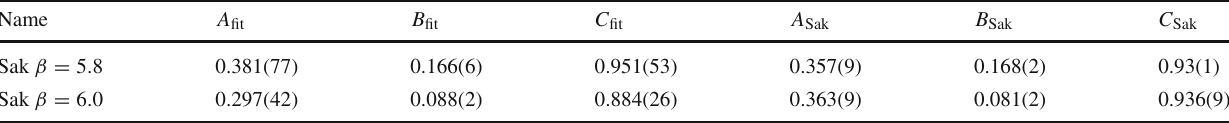
Fig. 5 Fit (blue solid line) to lattice data for the potential energy (red points) in the equilateral triangles configuration as a function of hyperradius R , using the Coulomb+linear Ansatz at a β = 5 . 8 Ref. [1]; b β = 6 . 0 Ref. [1]; c β = 6 . 0 Ref. [2] Table 1 Our and Sakumichi and Suganuma’s (from Table II in (1) C = C 3 Q . Error bars are in parentheses – note the substantial difference fitted constants in the 3-quark potential for equilateral triangles: the in the error bars of our fitted values and those in Ref. Coulomb coefficient A = 3 A 3 Q , the string tension B , and the constant